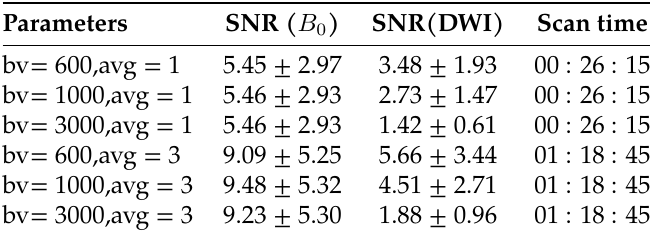
Table 2: SNR and acquisition times in raw data acquired at 0.3mm 3 .